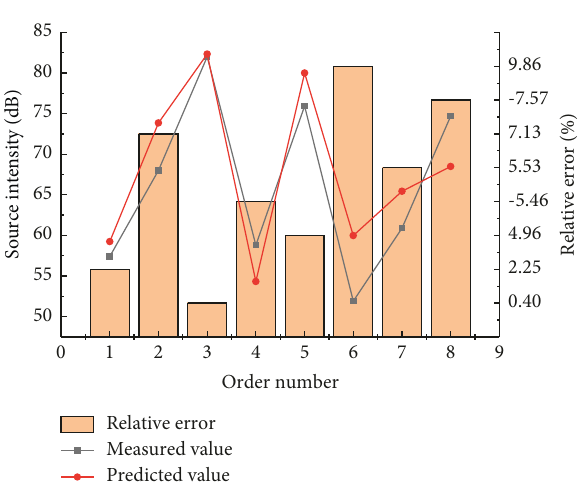
Figure 5: MSE of different node number of hidden layer.